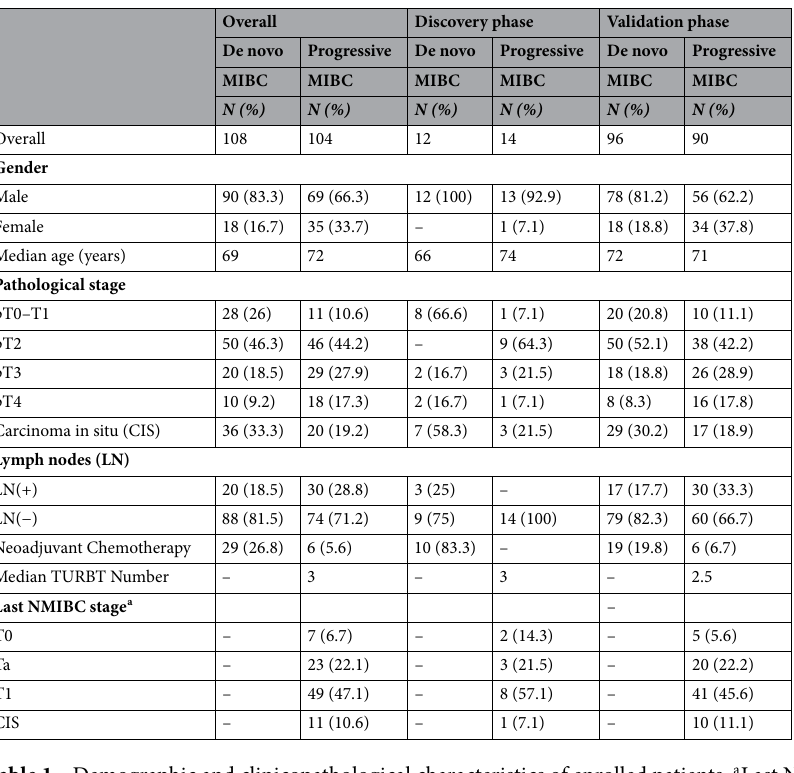
Table 1. Demographic and clinicopathological characteristics of enrolled patients. a Last NMIBC stage was not available in 14 progressive patients.